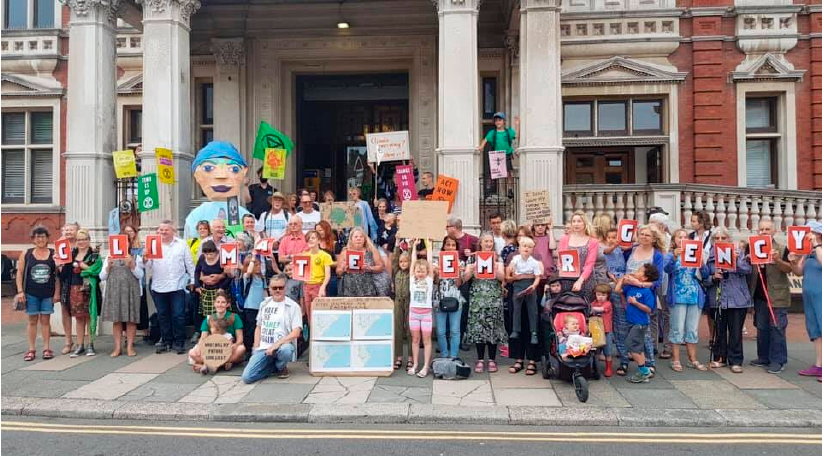
Figure 1. Protest outside Eastbourne Town Hall for Climate Emergency, 10 July 2019 @Courtesy of the Eastbourne Herald.